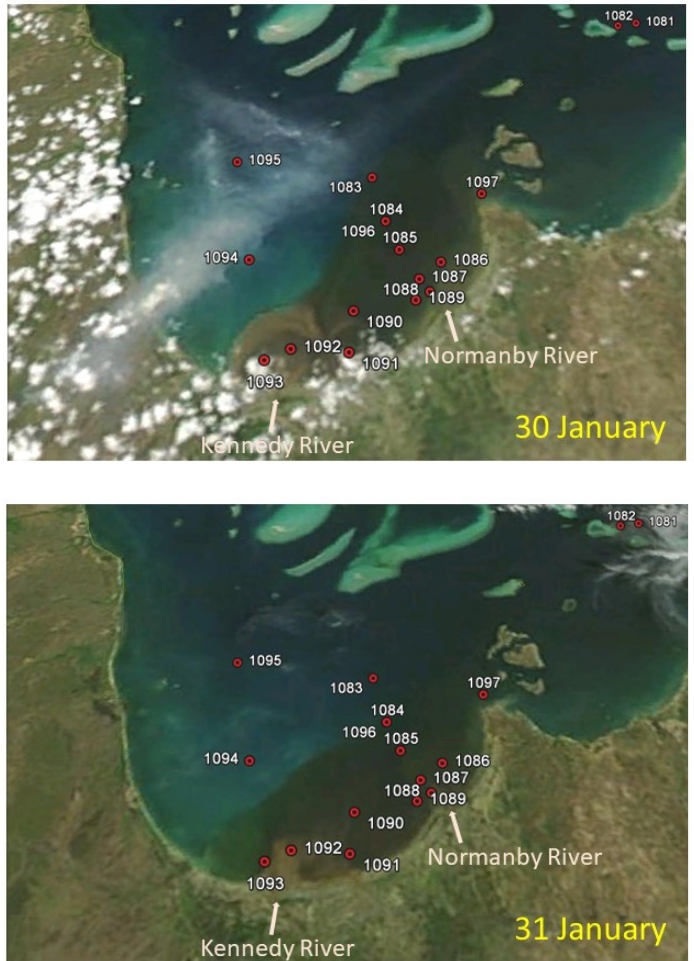
Figure 3. MODIS RGB (Red Green Blue) images on 30 January (Aqua) and 31 January, 2013 (Terra) showing the flood plumes, and the location of sampled stations (resolution: 250 m). St. 1081 to 1086 (eastern section of the bay) were sampled on 30 January, and st. 1087 to 1095 on 31 January, 2013. White shading in images denotes cloud cover.